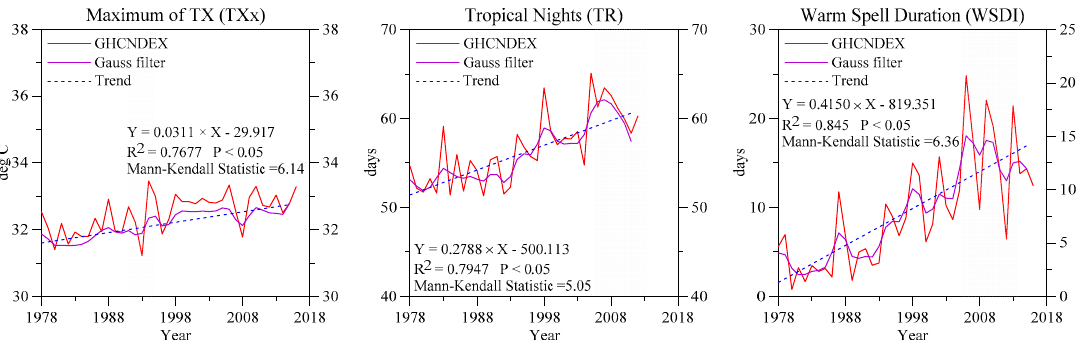
Figure 5. Time series of area-averages heat wave indices ( TXx , TR , and WSDI , and the gray area indicates a more significant variability) during the period 1979–2017 based on GHCNDEX data.